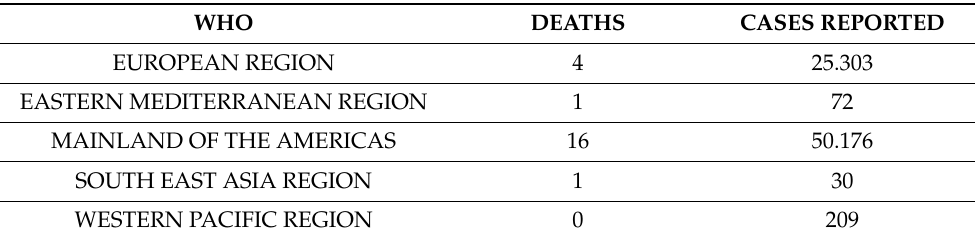
Table 2. The number of cumulative confirmed monkeypox cases and deaths reported to the WHO, by the WHO from 1 January 2022 to 30 October